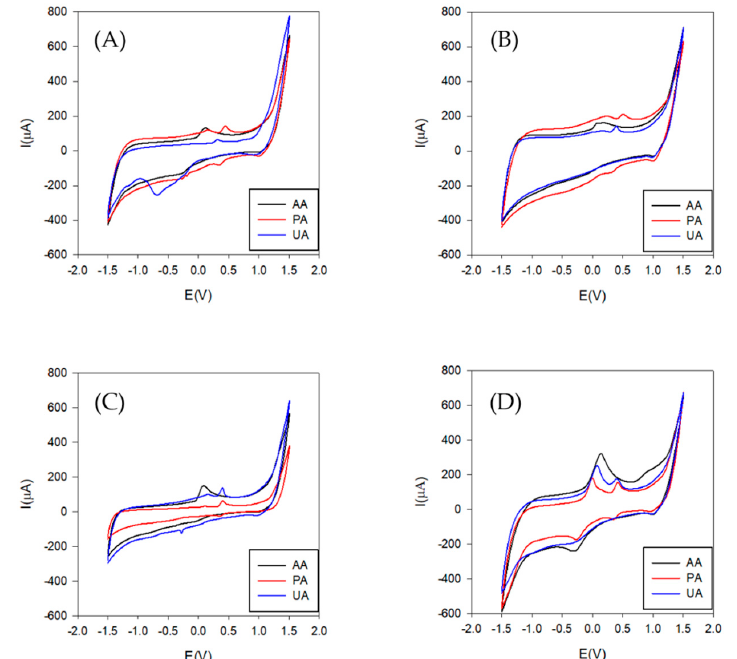
Figure 7. Voltammetric response for Acetaminophen (PA), Ascorbic acid (AA) and Uric acid (UA) using the four finally selected inks. ( A ) Cobalt (II) phthalocyanine/SPCE-Ink; ( B ) Prussian blue/SPCE-Ink; ( C ) Graphite/SPCE-Ink; ( D ) Copper oxide (II)/SPCE-Ink. The range of potential was from − 1.5 to 1.5 V. The scan rate was 50 mV · s − 1 and step rate of 9 mV. A 300 µ mol · L − 1 individual solution was employed for the four modified screen-printed